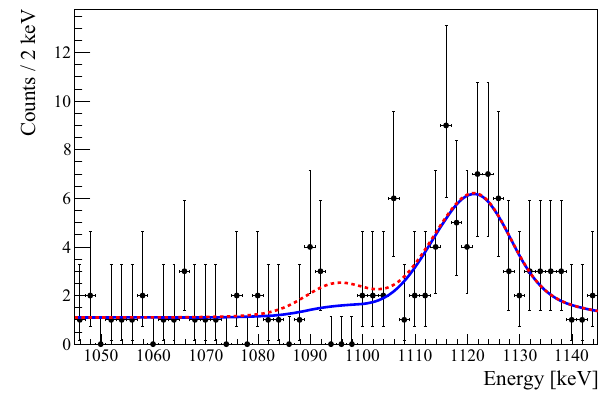
Fig. 5 Zoom of the blue spectrum reported in Fig. 3 in the energy region of interest for signature D (1094.9keV). The number of events is small because we required the time-coincidence with a 511keV γ - ray (see main text). We fit this spectrum with the signal model, an exponentially decreasing background and a peaking background due to 65 Zn. Dotted line: a hypothetical signal corresponding to the 90% CI limit set in this